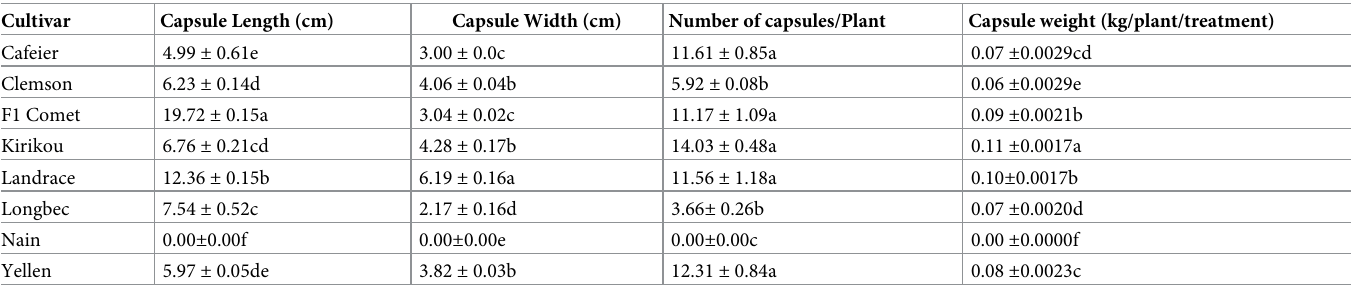
Table 17. Yield components of okra cultivars cultivated.